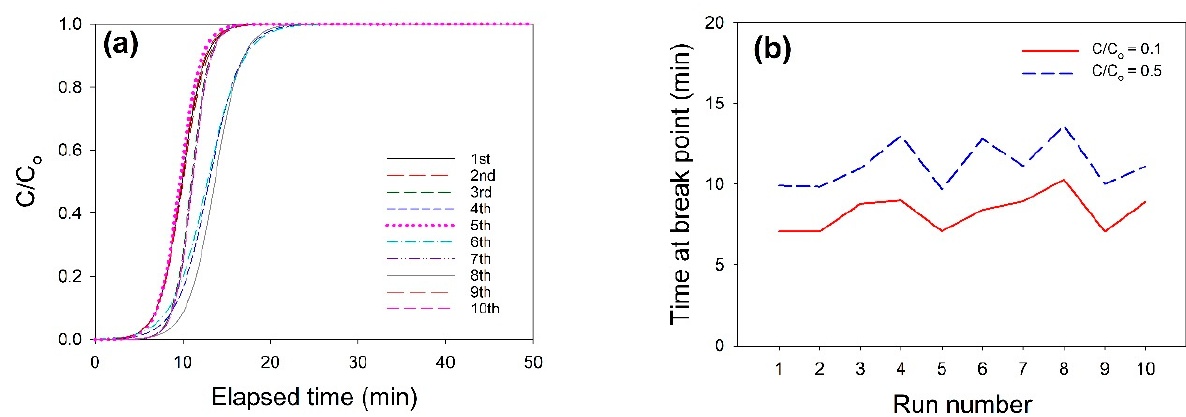
Figure 10. ( a ) Successive cyclic adsorption breakthrough curves, and ( b ) the variation of time at C/C 0 = 0.1 and 0.5.